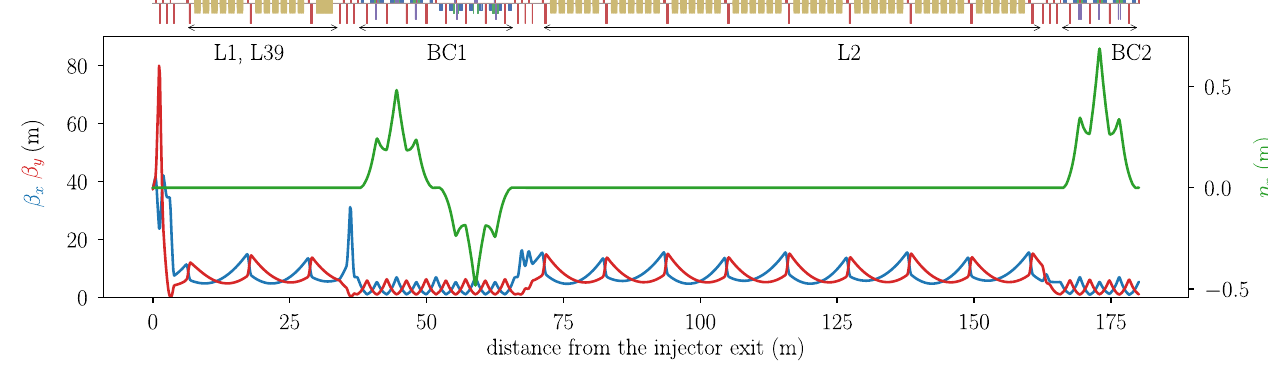
FIG. 12. Evolution of the betatron (left axis) and horizontal dispersion (right axis) functions along the proposed linac. The vertical dispersion is zero throughout the linac. The magnetic-lattice color coding for the element follows Fig. 9 with the accelerating cavities shown as gold rectangles.